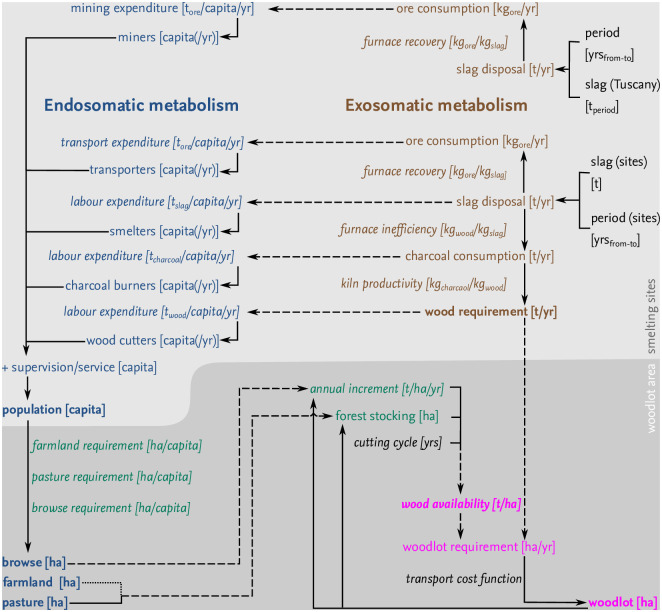
Sketch of the model.